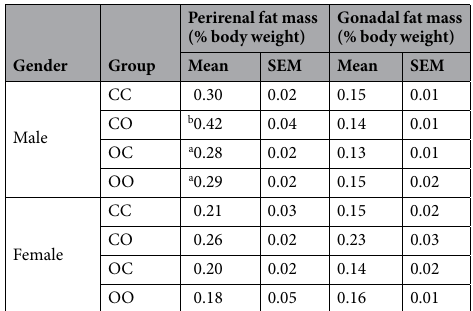
Table 1. Offspring adipose tissue mass at 2 weeks of age. Values are for mean and SEM. Four groups of cross- fostered offspring were studied: offspring exposed to a chow diet during pregnancy cross-fostered to a chow fed dam during lactation (CC, n 15–16) or a cafteria fed dam (CO, n 12–16), offspring exposed to a cafeteria diet during pregnancy cross-fostered to a chow fed dam during lactation (OC, n 16) or a cafeteria fed dam (OO, n 9–12). Some animals were excluded from the analysis due to assessment of extreme outliers or data missing. a Effect of maternal pregnancy diet on offspring perirenal adiposity using two-way ANOVA (males only) ( P = 0.005). b Interaction effect of maternal pregnancy and maternal lactation diet on offspring perirenal adiposity using two-way ANOVA (males only) ( P =